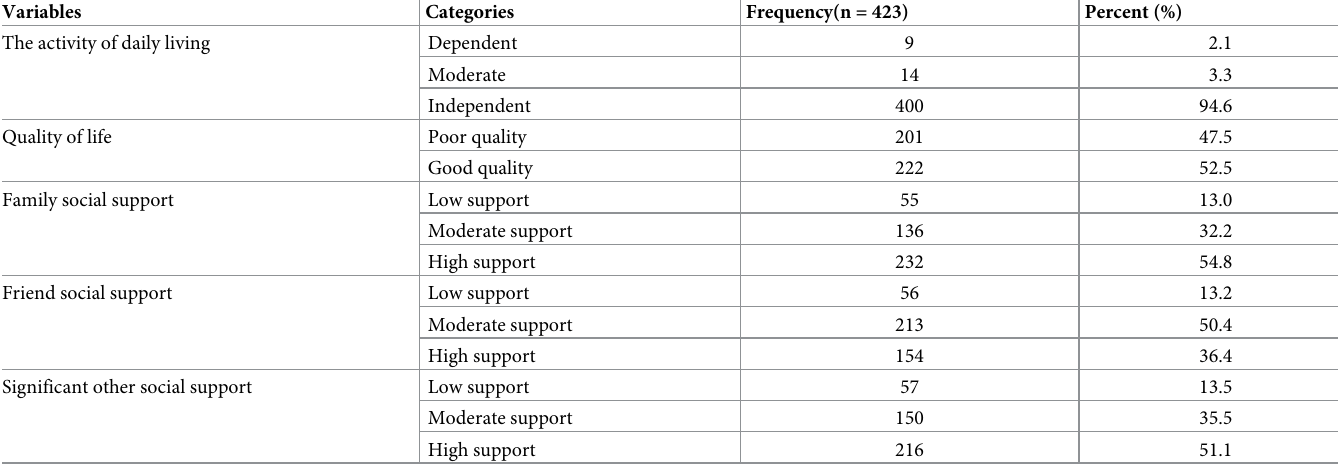
Table 3. Psychosocial characteristics of older adults people in Bahir Dar city administration, northwest, Ethiopia, 2020 (n = 423).